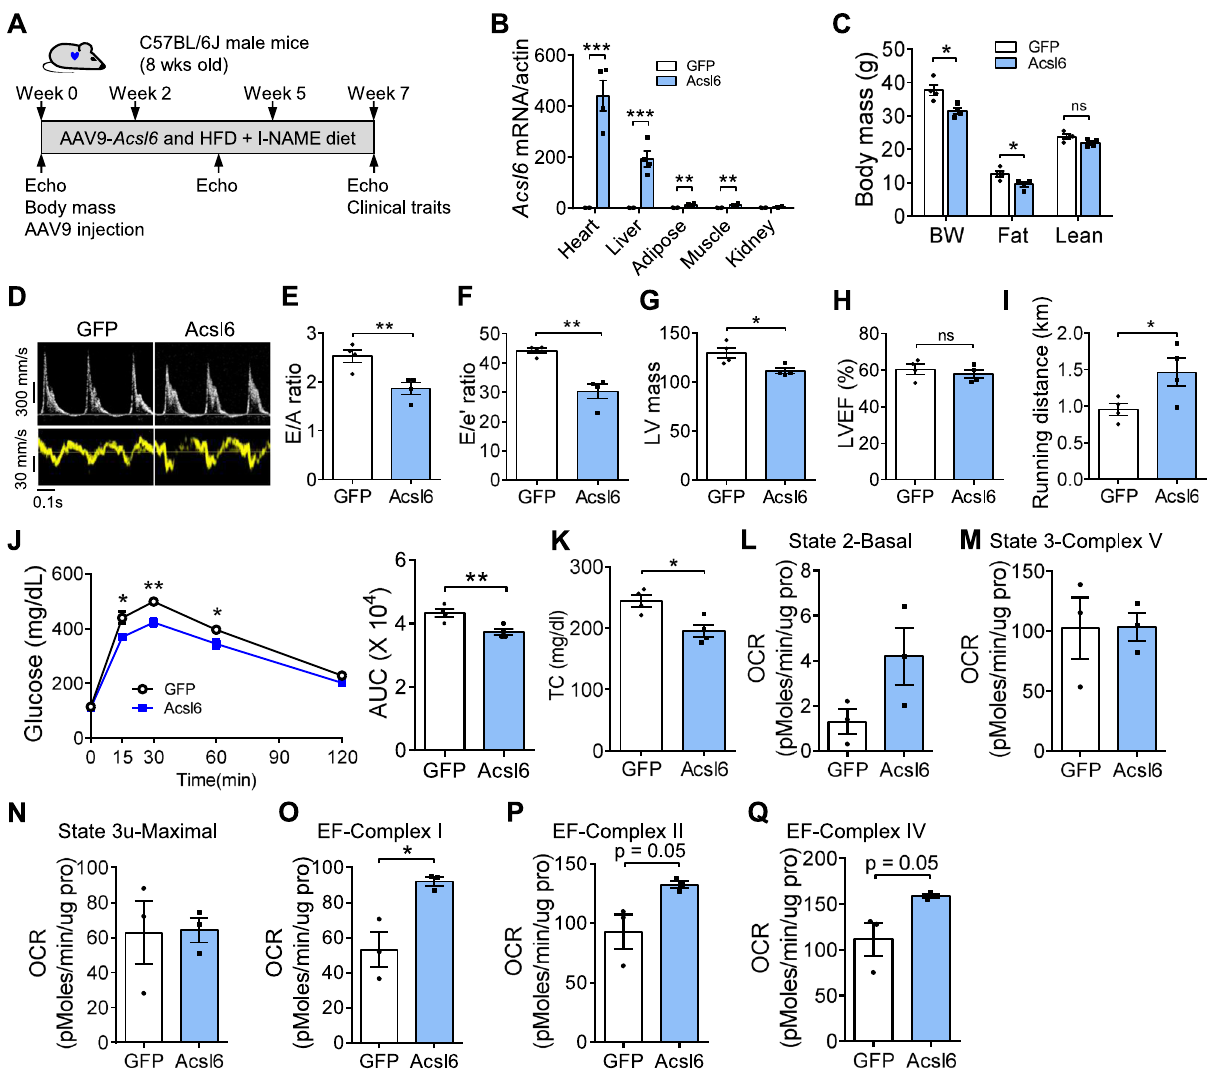
Fig. 6 Acsl6 improves diastolic function and mitochondrial function in C57BL/6J male mice in HFpEF model. C57BL/6 J male mice (8 weeks old) were injected with AAV9-GFP and AAV9- Acsl6 . Mice were fed with HFD + l-NAME for 7 weeks to induce HFpEF. After feeding, diastolic function and mitochondrial function were examined. A Experimental timeline. B qRT-PCR showing Acsl6 expression in the heart, liver, adipose tissue, skeletal muscle, and kidney after AAV injection. N = 4. p (heart) = 0.0003; p (liver) = 0.0008; p (adipose) = 0.002; p (muscle) = 0.004. C Body composition. BW body weight, Fat fat mass, Lean lean mass. N = 4. p (BW) = 0.015; p (fat) = 0.033. D – H Representative images of echo echocardiography ( D ), E/A ratio ( E ), E/e ’ ratio ( F ), LV mass ( G ), and LVEF ( H ) were examined. N = 4. E p = 0.009. F p = 0.002. G p = 0.025. I – K Running distance ( I ), glucose-tolerance test and area under curve (AUC, J ), and plasma total cholesterol ( K ) were examined after the feeding. N = 4. I p = 0.049. J p = 0.009. K p = 0.012. L – Q OCR of isolated heart mitochondria were measured by Seahorse assay. The coupling assay measures basal respiration in presence of palmitoyl-carnitine, state 3 (ADP) and state 3 u (FCCP). The electron fl ow measures complex I (palmitoyl-carnitine), complex II (succinate), and complex IV (TMPD) respiration. N = 3. O p = 0.018. Each point represents a mouse. All data are presented as the mean ± SEM. ns not signi fi cant, * P < 0.05, ** P < 0.01, and *** P < 0.001, by two-sided Student ’ s t -test. Source data are provided as a Source Data fi